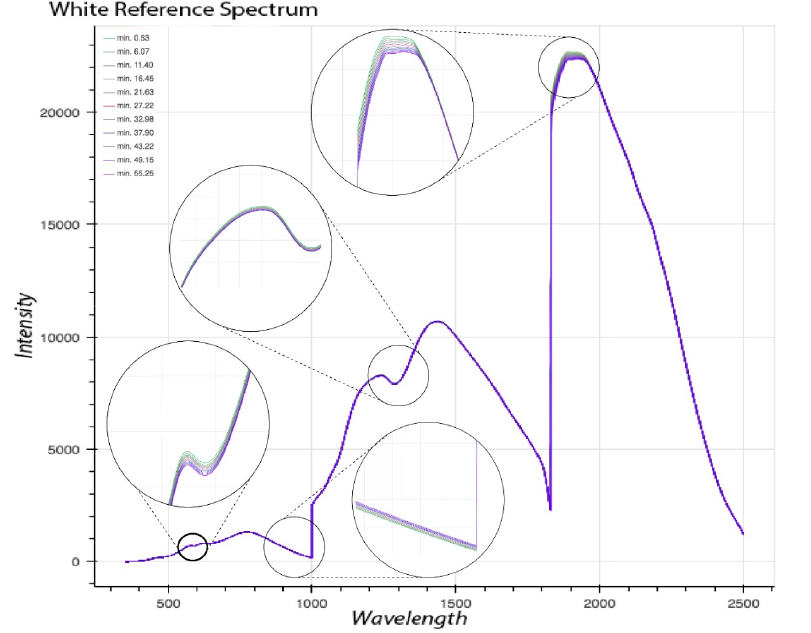
Figure 9. Global view of the 11 spectra of the available white